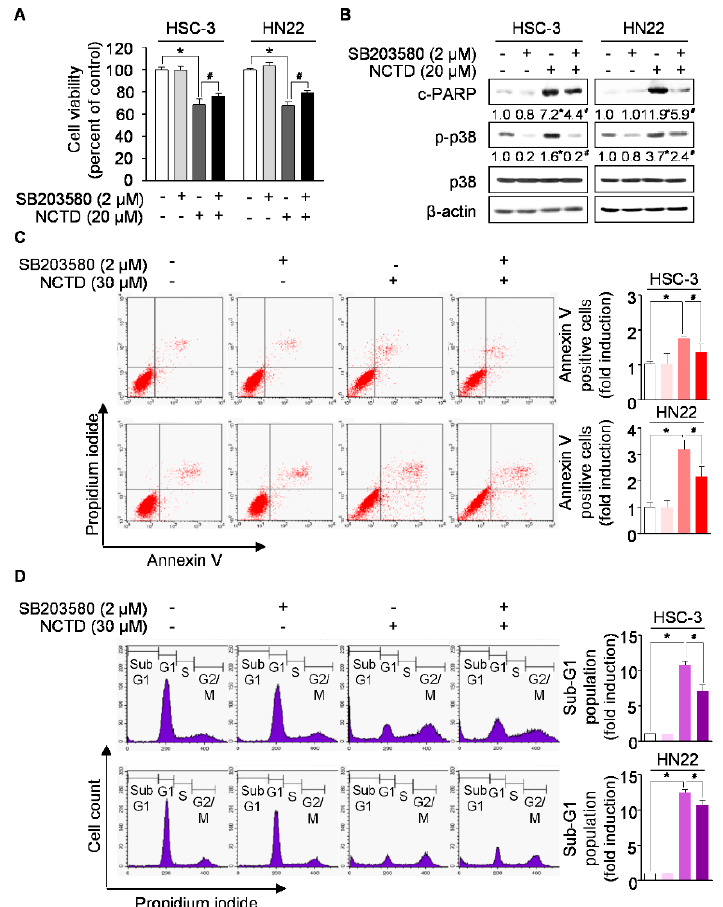
Figure 4. The role of p38 MAPK on NCTD-induced programmed cell death. HSC-3 and HN22 cells were pretreated with a p38 MAPK inhibitor (2 µ M SB2035280) for 1 h, and certain concentrations of NCTD were added for 48 h. ( A ) Cell viability was analyzed by a trypan blue exclusion assay. ( B ) Western blotting was performed to detect the protein levels of cleaved PARP, p-p38, and p38. ( C ) Apoptotic cells were detected by the annexin V / PI double-staining. ( D ) Sub-G 1 population was analyzed by PI staining. The graph represents the mean ± SD of three independent experiments, and significance compared with the control group was indicated (* p < 0.05). Significance compared with the NCTD-treated group was indicated ( # p < 0.05).